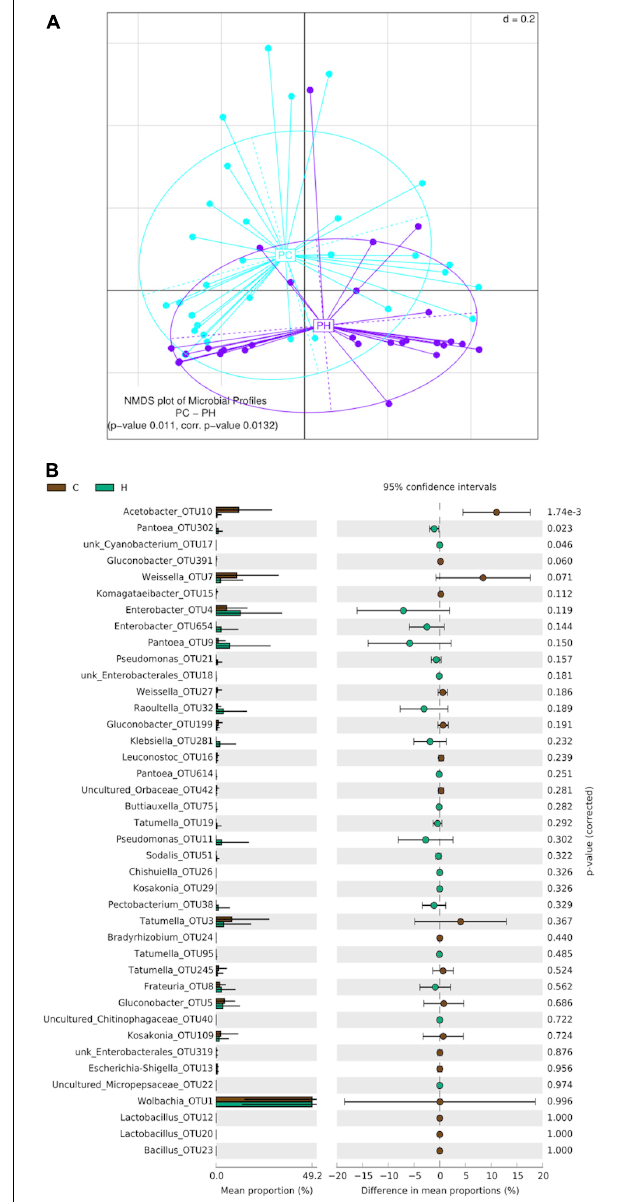
FIGURE 6 | Effect of geographic origin on the larval gut bacteriome of wild Anastrepha fraterculus sampled in guava fruit. (A) Meta Non-metric Multidimensional scaling (meta NMDS) plot representing sample groups according to the area where fruit was collected: C (Concordia, Entre Ríos) or H (Horco Molle, Tucumán). Not significant p -value from PERMANOVA analysis; d = 0.2. (B) Origin effect on OTUs relative abundance mean: the plot presents the mean proportion of reads for each OTU to the left (bars show mean value and standard error) the difference in mean proportions for each pair of comparisons (as well as its associated p -value according to Welch’s T -test).